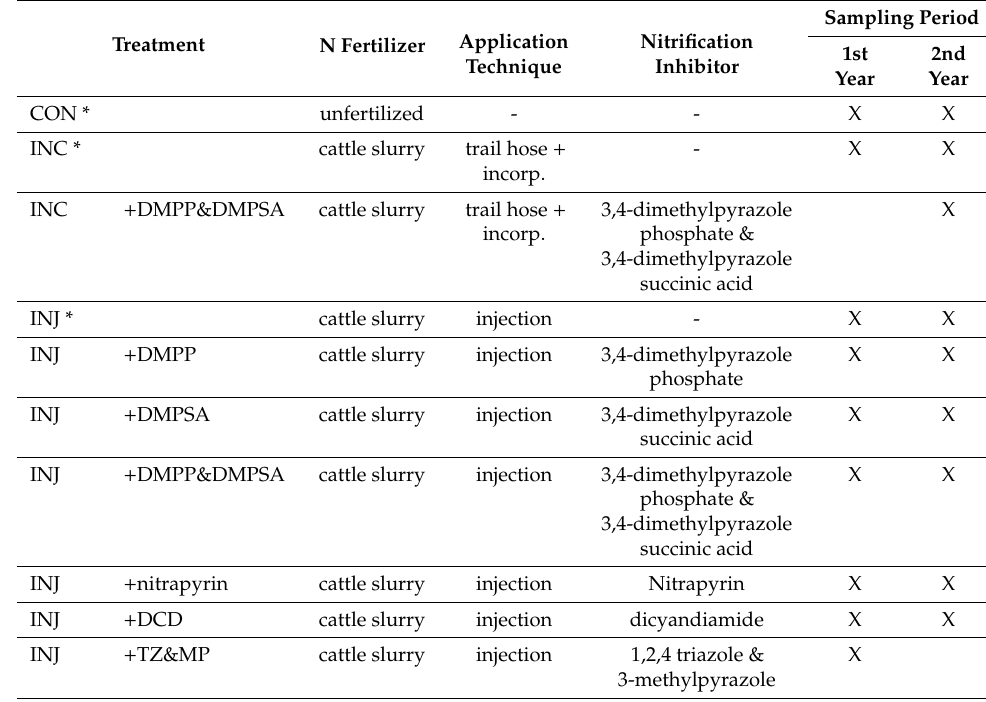
Table 1. Abbreviation of the di ff erent treatments with N fertilizer form, application technique, nitrification inhibitor added (active substances), and sampling